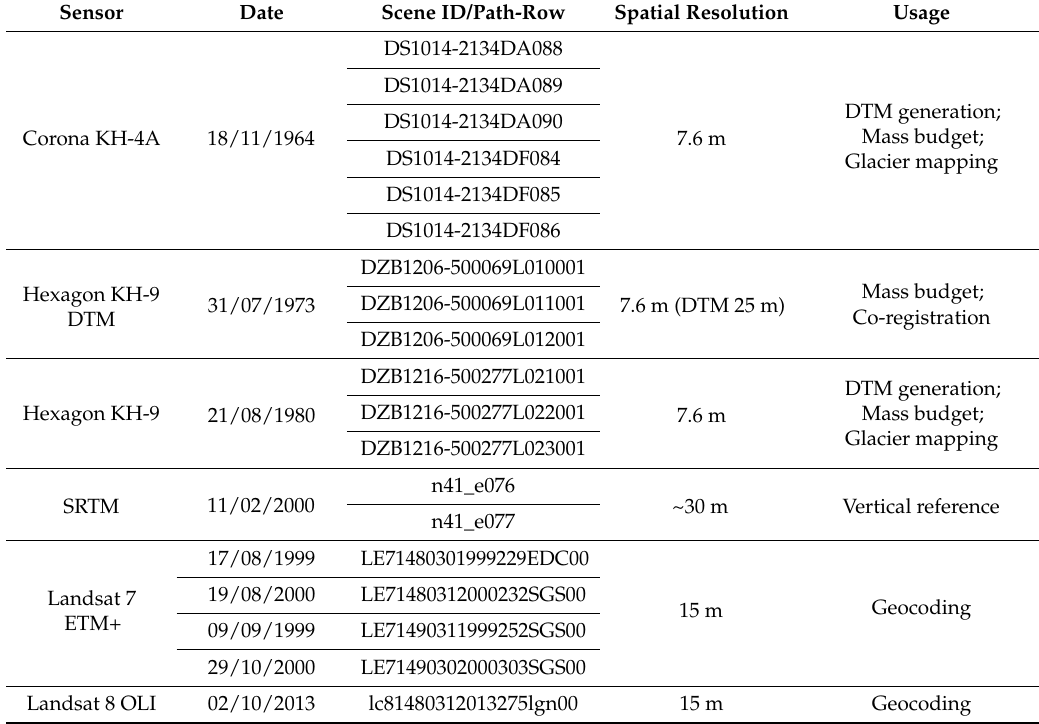
Table 1. Input datasets.